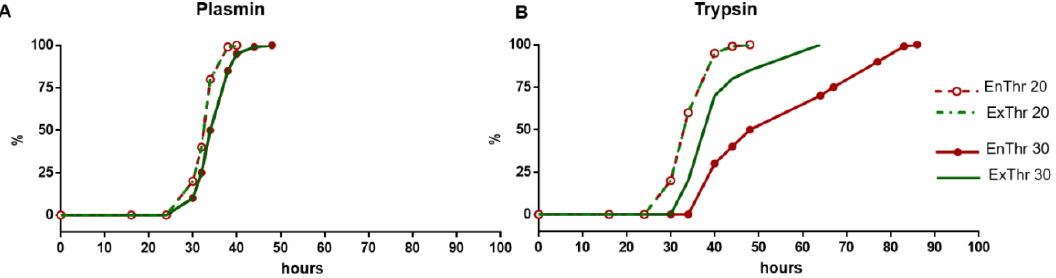
Figure 4. Degradation rate of fibrin matrices prepared at fibrinogen concentrations of 20 and 30 mg/mL using endogenous (EnThr) and exogenous (ExThr) thrombin: ( A ) fibrin degradation by 0.1 U/ml plasmin; ( B ) fibrin degradation by 0.1% trypsin .